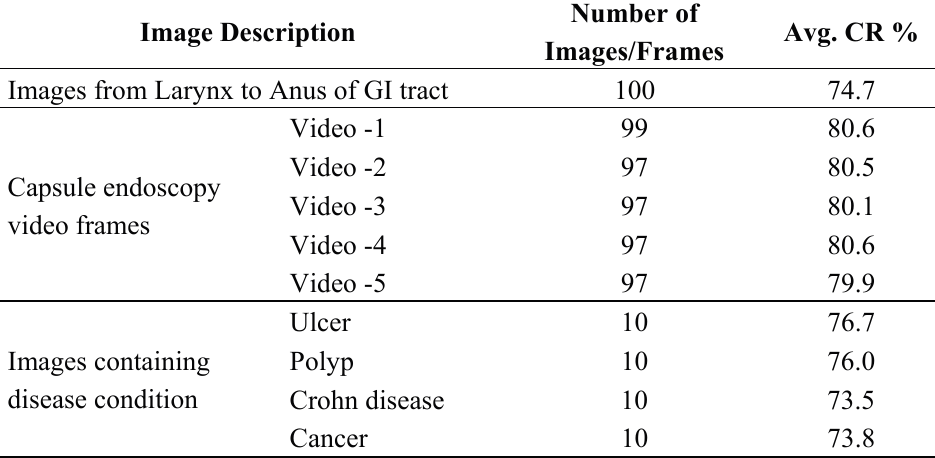
Table 4. Compression ratio of the proposed algorithm for WLI